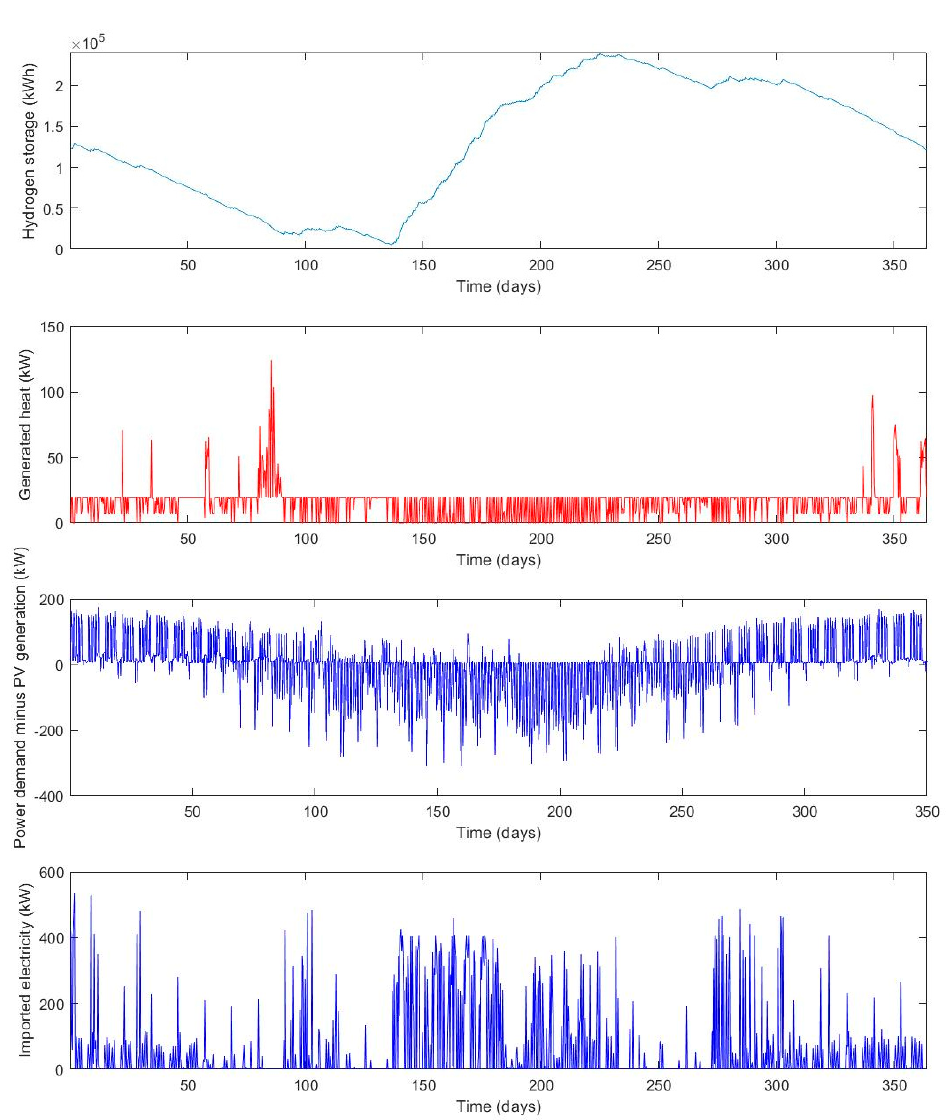
Figure A9. Optimal operation of a 100/400 kW RSOC system with 3000 m 2 solar PV panel.